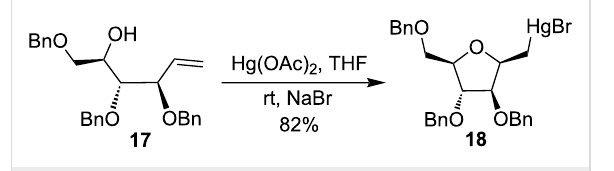
Scheme 8: Synthesis of β - ᴅ -arabinose derivative 18 .